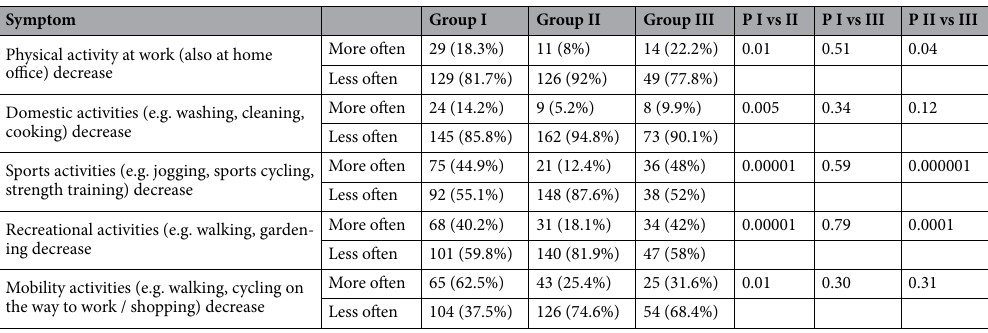
Table 5. Comparison of selected physical activity parameters in patients who have experienced COVID-19 (Group I) in comparison to with coronary heart disease patients (Group II) and Bialystok Plus Group (Group